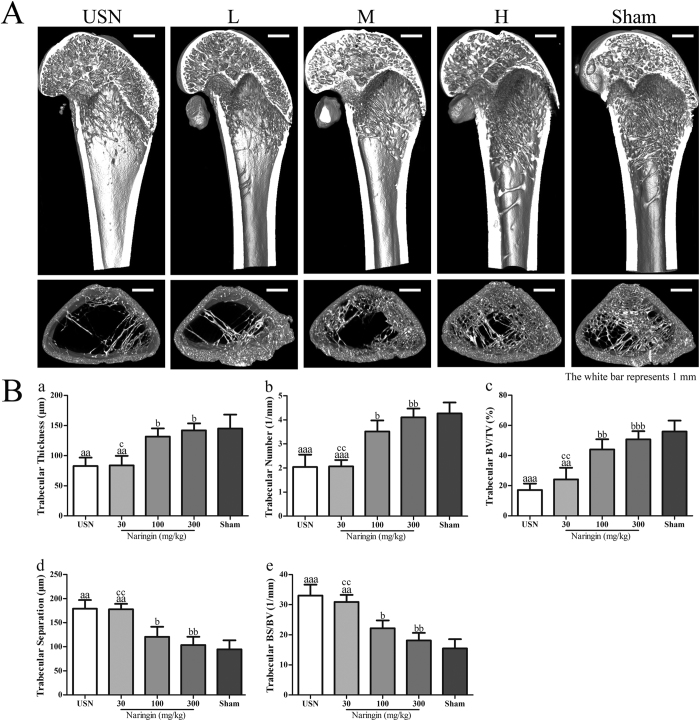
Effects of naringin on the protection of the trabecular microstructure as analysed by Micro-CT scanning.The region of interest (ROI) that was chosen for analysis was a region 25–125 slices away from the distal femoral growth plate at the distal femoral metaphysis. The thickness of a slice was 21 μm. (A) Representative 3D images showing the trabecular microarchitecture in the distal femoral metaphysis of each group. (B) Micro-structure parameters of the distal femoral trabecula as analysed from Micro-CT scanning data. Naringin at higher doses prevents the femoral trabecular micro-structure from deteriorating by immobilization at 4 weeks. L represents the 30 mg/kg Naringin group, M the 100 mg/kg Naringin group, and H the 300 mg/kg Naringin group. (a) represents the trabecular thickness (Tb.Th), (b) the trabecular number (Tb.N), (c) the trabecular bone volume fraction (BV/TV), (d) the trabecular separation (Tb.Sp) and (e) the surface/volume ratios (BS/BV). ap < 0.05, aap < 0.01, aaap < 0.001 vs. Sham group. bp < 0.05, bbp < 0.01, bbbp < 0.001 vs. USN group. cp < 0.05, ccp < 0.01, cccp < 0.001 vs. 300 mg/kg Naringin group. One-way ANOVA.